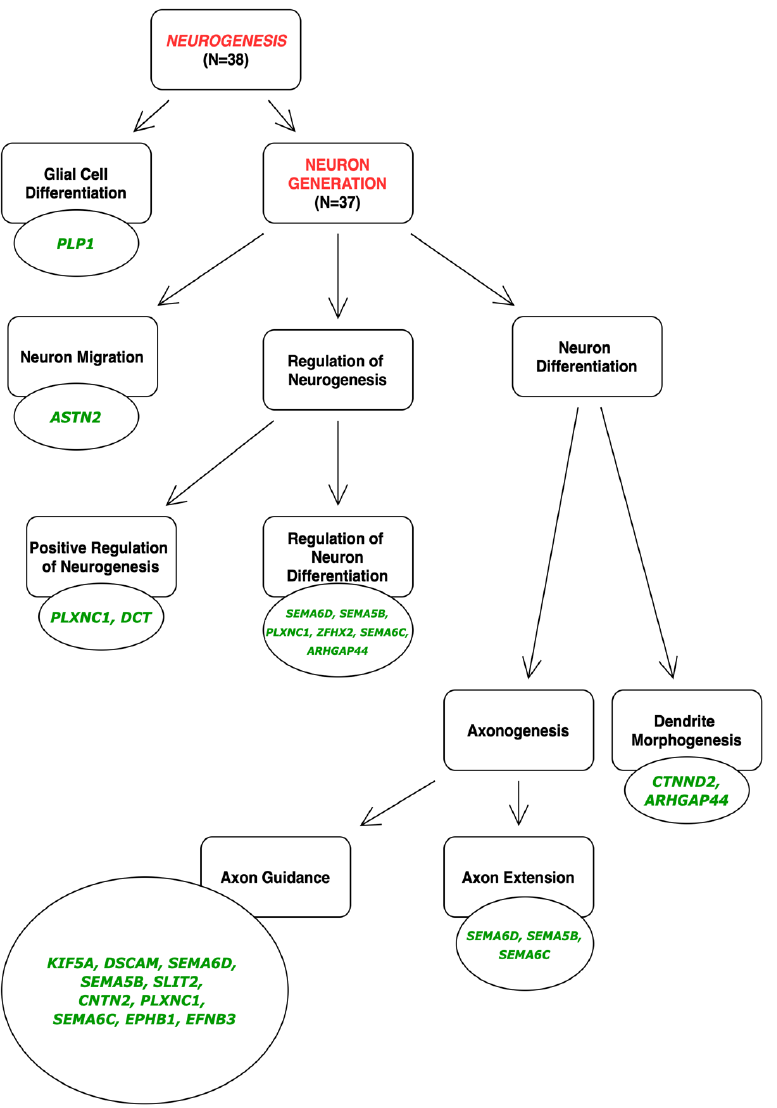
Figure 11. Upregulated pathways associated with neurogenesis in a high-density neural progenitor cell culture. Molecules and transcription factors involved in neuronal differentiation, production of axons (axonogenesis; morphogenesis), and subsequent guidance ques are all significantly upregulated. Pathway analysis completed with PANTHER.